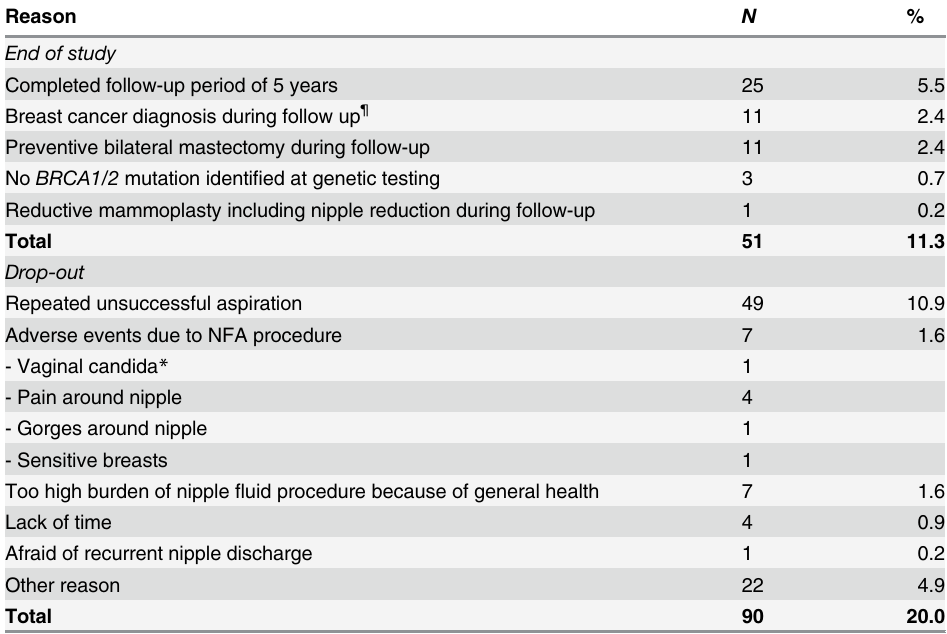
Table 4. Reasons for leaving the study of repeated NFA in 451 women at increased breast cancer